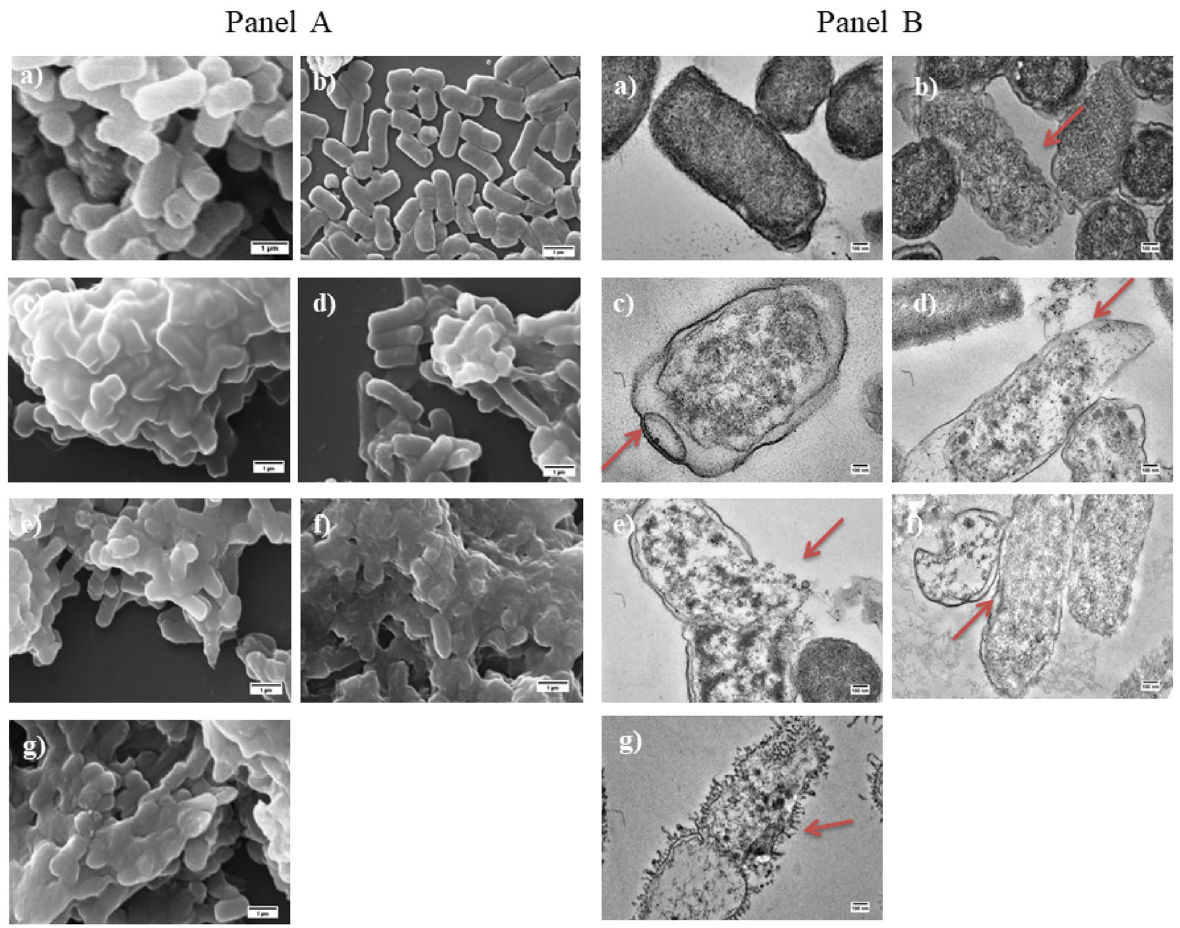
Figure 7. Panel ( A ): Scanning electron micrographs and Panel ( B ): Transmission electron micrographs of E. coli ATCC 25922 after the treatment with α-MSH and its analogues at 100 µM of concentration; (a) Untreated E. coli cells, and cells treated with (b) α-MSH, (c) K-MSH, (d) KK-MSH, (e) KKA-MSH, (f) KKK-MSH, and (g) 12 µg/mL of polymyxin B at a magnification of 30,000×. Scale bar = 1 µm. Red arrows indicate the major membrane alteration sites in the peptide-treated